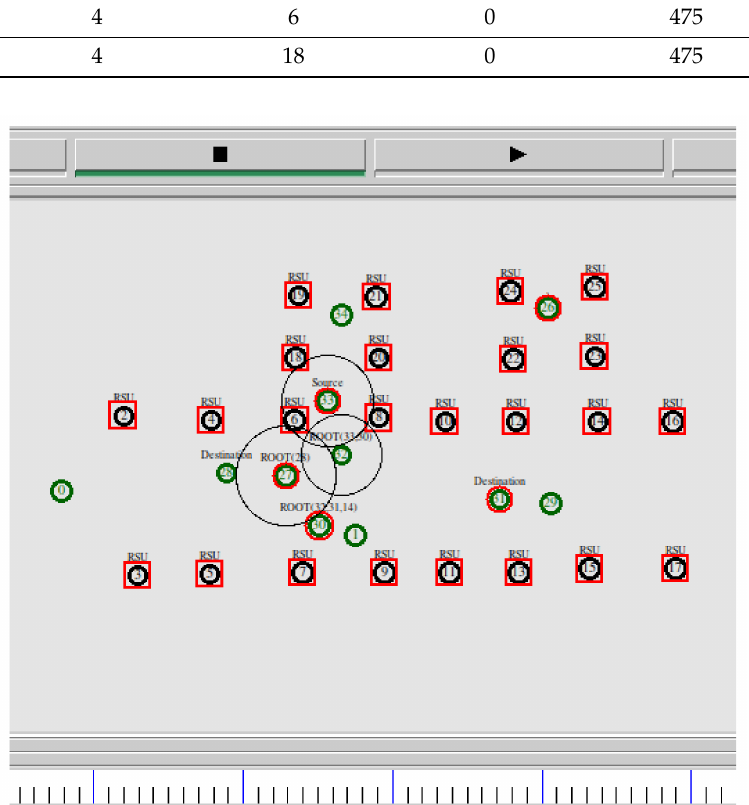
Figure 9. Appropriate load balancing between source to